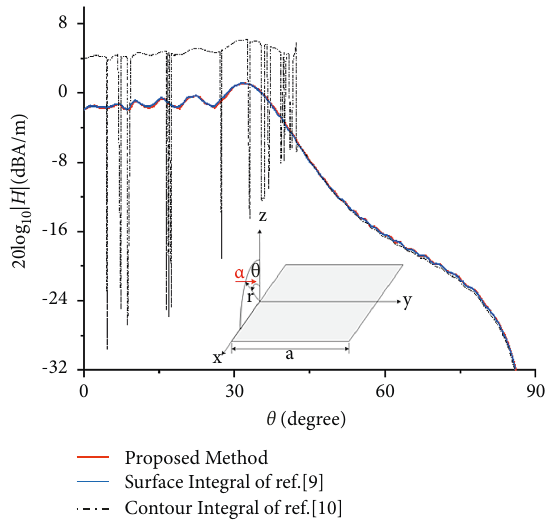
Figure 2: Scattering comparison by the local expansion.